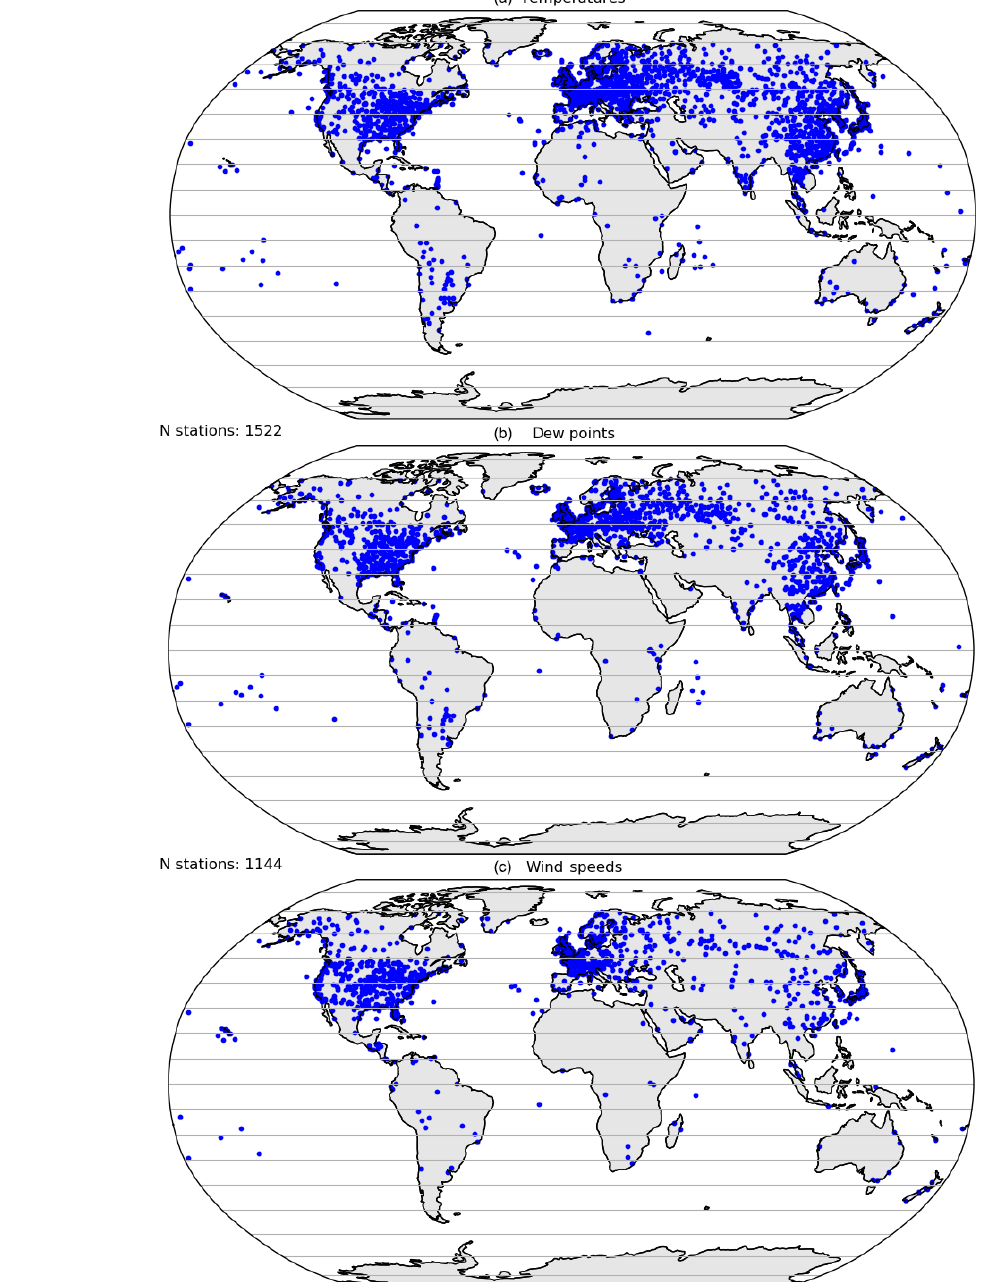
Figure 1. Maps showing the locations of HadISD stations contributing to the zonal analysis along with the 10 ◦ latitude bands for (a) tem- perature, (b) dew points and (c) wind